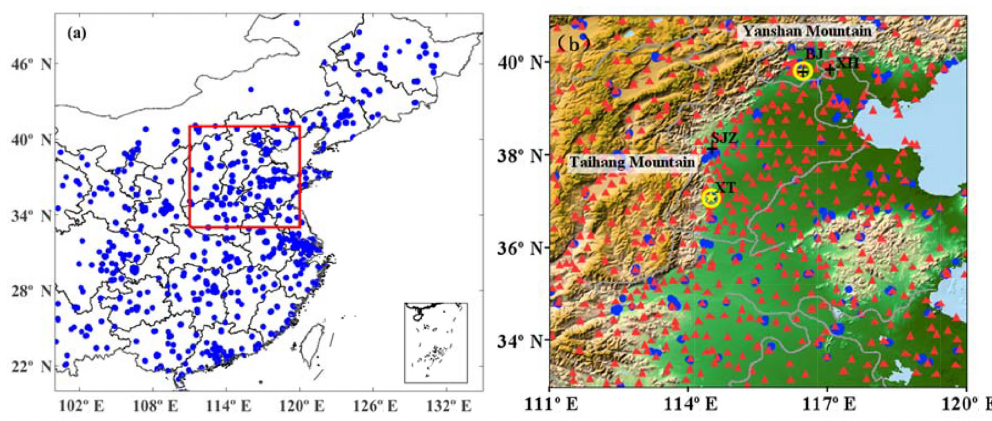
Figure 1. (a) Model domain and location of the Jing–Jin–Ji region. (b) Geographic location and topography of Jing–Jin–Ji. Blue dots are the locations of PM 2 . 5 observations, red triangles are the locations of automatic weather stations, yellow stars are the two sounding stations, and black crosses are the CARSNET and AEROSNET stations.